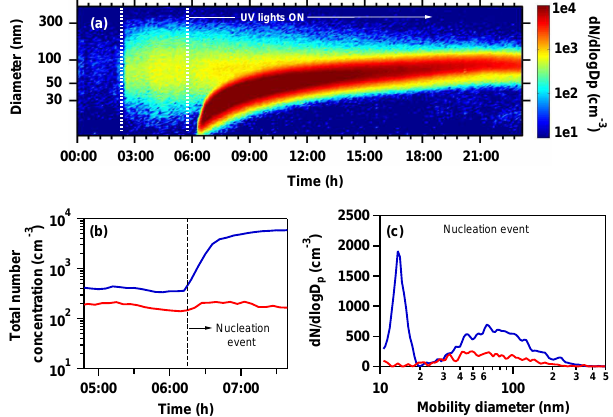
Figure 3. (a) Time evolution of particle number size distribution during the induced ambient nucleation experiment, measured after the BP line at 25 ◦ C. The stages of the experiment were measure- ment of chamber background (00:00 to 02:30), introduction of am- bient air in the chamber (02:00 to 06:00), nucleation event (06:00 to 09:00), and fresh SOA formation (09:00 to 23:00). (b) Total number concentration of ambient particles introduced in the chamber (04:45 to 06:15) and of particles after nucleation occurs (06:15 to 07:45) as a function of time. (c) the number size distribution during the nucle- ation event (at 06:15) at 25 ◦ C (blue) and 400 ◦ C (red). The Aitken mode (30–300nm) consists mainly of ambient